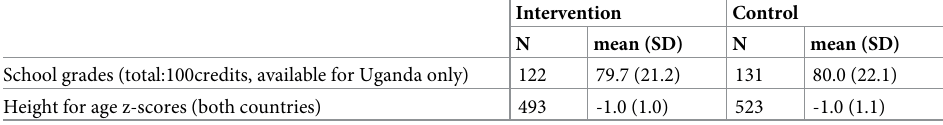
Intervention Control N mean (SD)